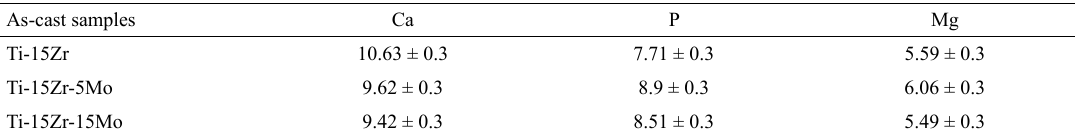
during MAO treatment was not affected by the substrate’s chemical